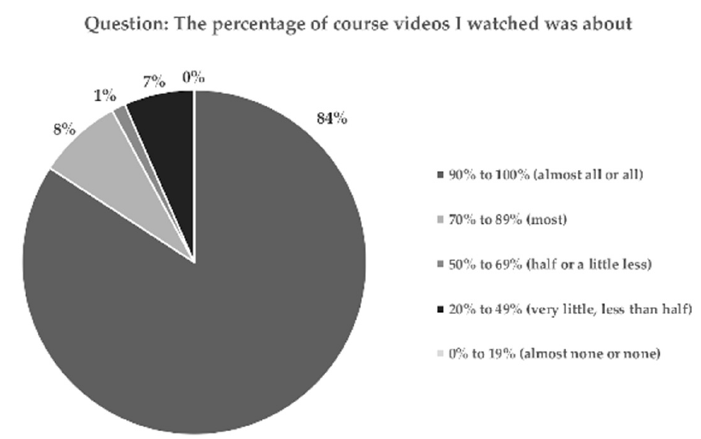
Figure 8. Percentage of course videos watched by students.